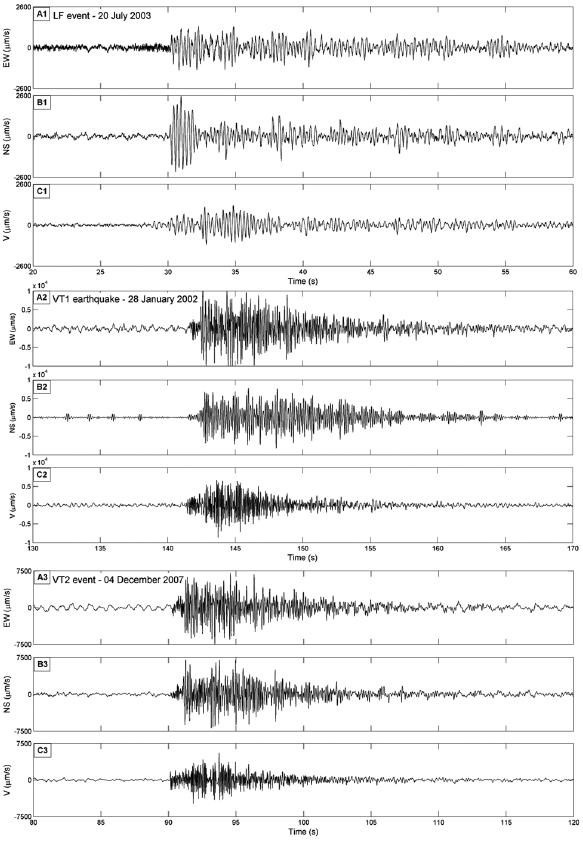
Figure 3. Analyzed event seismograms. 1) The LP event seismo- grams: A) EW, B) NS and C) V component of ground velocity recorded at BKE station. 2) The VT1 seismograms: A) EW, B) NS and C) V component of ground velocity recorded at BKE station. 3) The VT2 seismograms: A) EW, B) NS and C) V component of ground velocity recorded at BKE